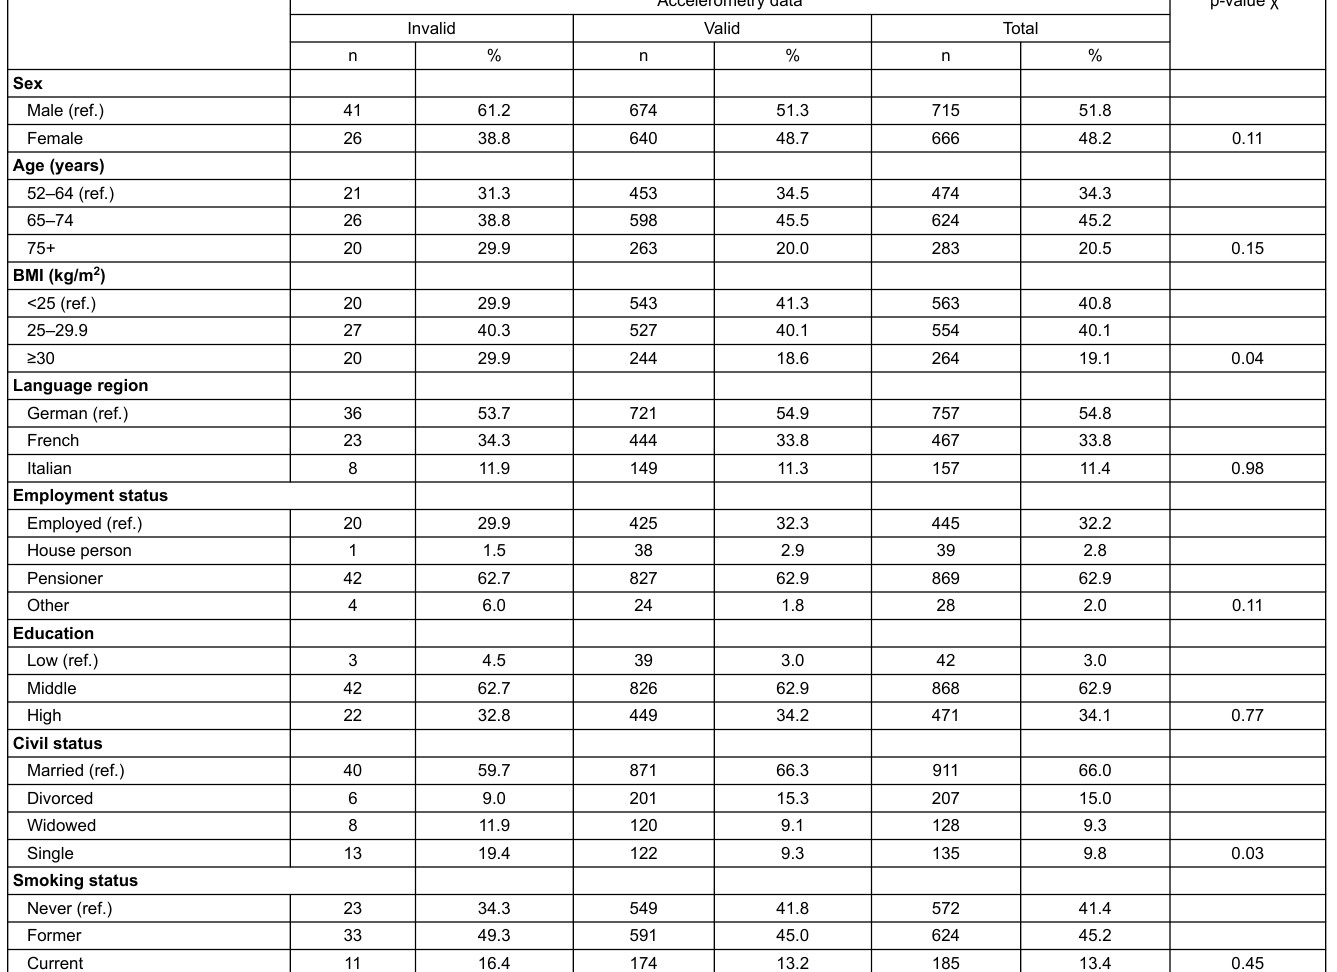
Table S2: Characteristics of participants at the time of the accelerometry study (SAPALDIA4) according to the validation status (at least 10 hours wear time per day; at least three valid weekdays and at least one valid weekend